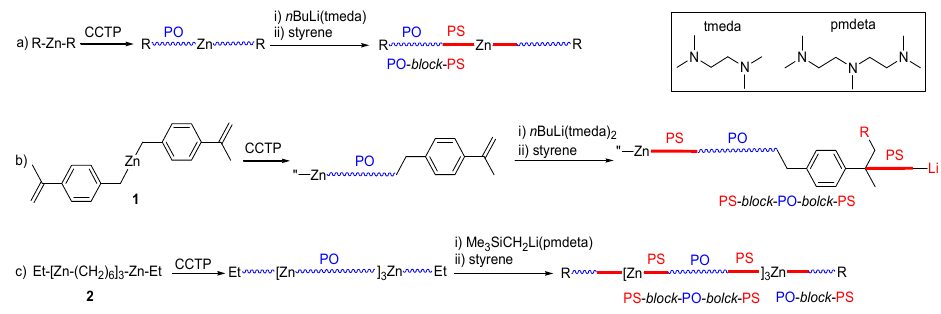
Scheme 1. ( a – c ) Previously attempted strategies for preparation of polyolefin-polystyrene (PO-PS) block copolymers.